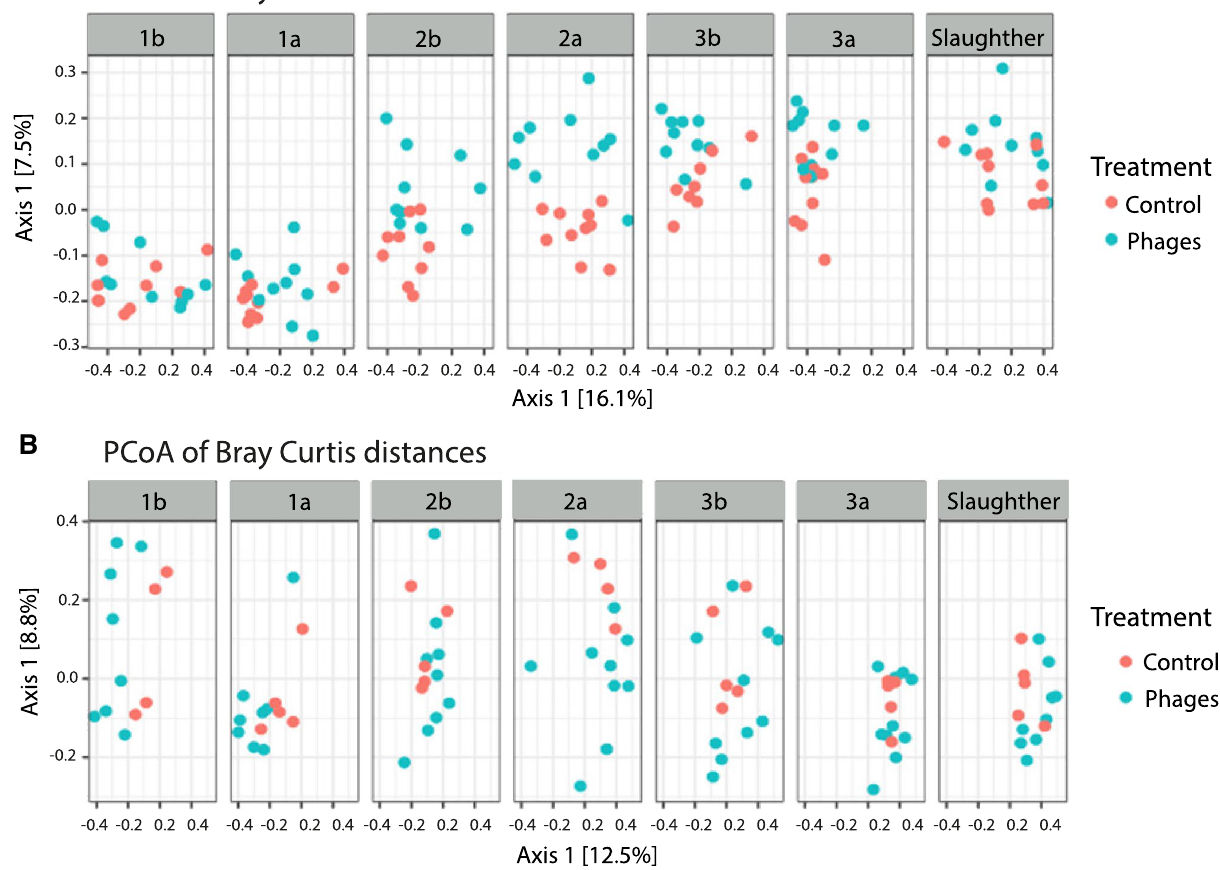
Figure 6. Principal Coordinate Analysis (PCoA) representing the similarity of bacterial communities found in the cecum of broiler chicken treated with (phages) and without (controls) the bacteriophage cocktail, measured using the Bray Curtis metric. Axes represent the coordinates of the samples in Axis 1 and 2 of the corresponding PCoA plots. Blocks of samples are divided by dose day and nomenclature as described in Fig. 1. Upper panel display Trial 1 ( A ) and the lower panel Trial 2 ( B ). This figure was generated using Phyloseq package in R v 1.2.5 (https:// www.r- proje ct.